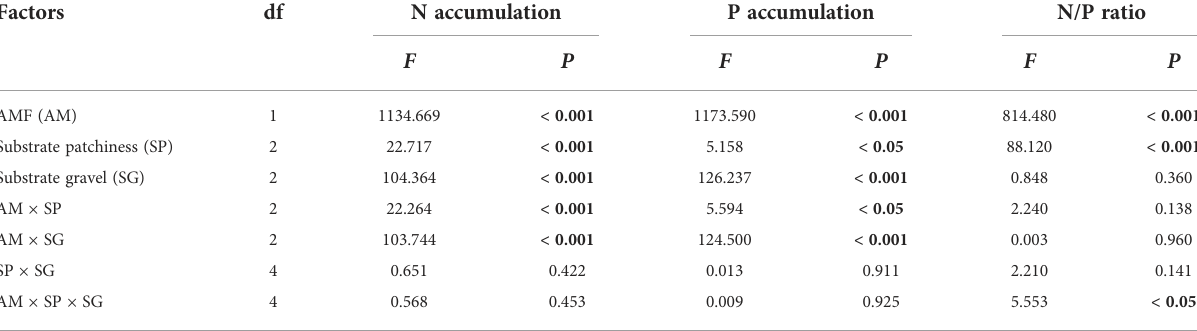
TABLE 3 The three-way ANOVA for the effects of AMF (M + vs. M - ), substrate patchiness (Homo vs. Hetl vs. Hets) and substrate gravel (LG vs. FG vs. HG) treatments on the N accumulation, P accumulation, and N/P ratio of B. pilosa . Factors df N accumulation P accumulation N/P ratio